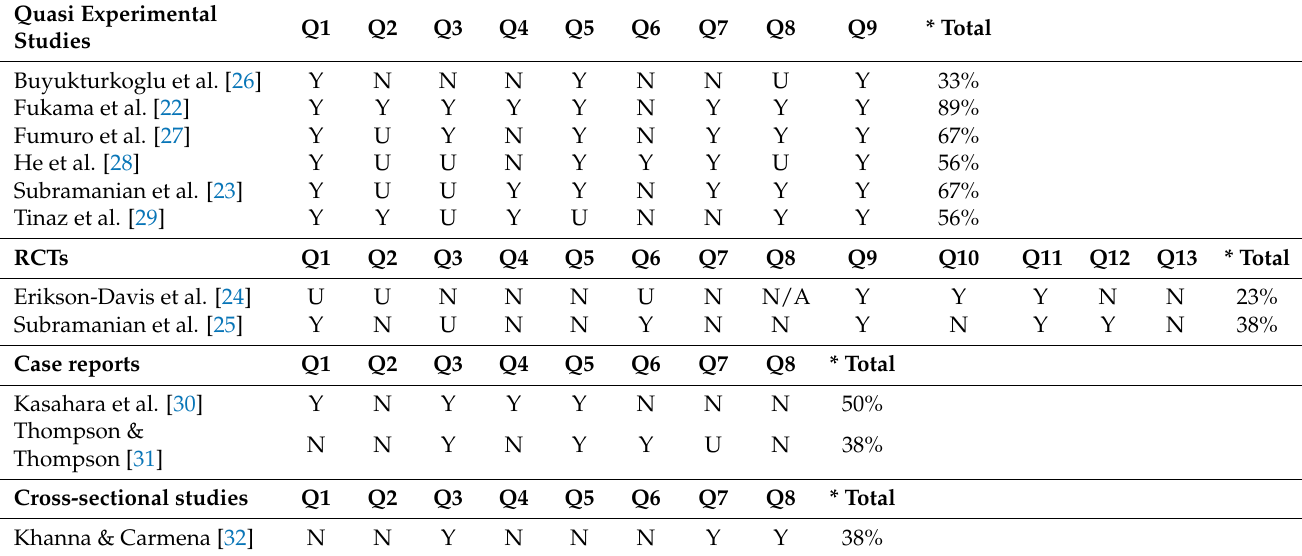
Table 1. Methodological assessment of included studies using critical appraisal instruments from the Joanna Briggs Institute. Quasi